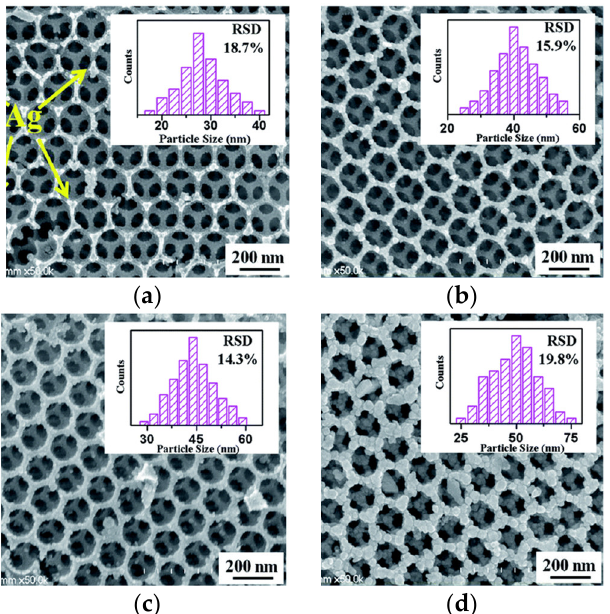
Figure 9. SEM images of PCs modified with Ag by the pulsed current deposition method during: ( a ) 15 s-Ag/TiO 2 , ( b ) 30 s-Ag/TiO 2 , ( c ) 45 s-Ag/TiO 2 , and ( d ) 60s-Ag/TiO 2 ; Reprinted with permission (after formatting) from [99]. Copyright (2014) RSC.